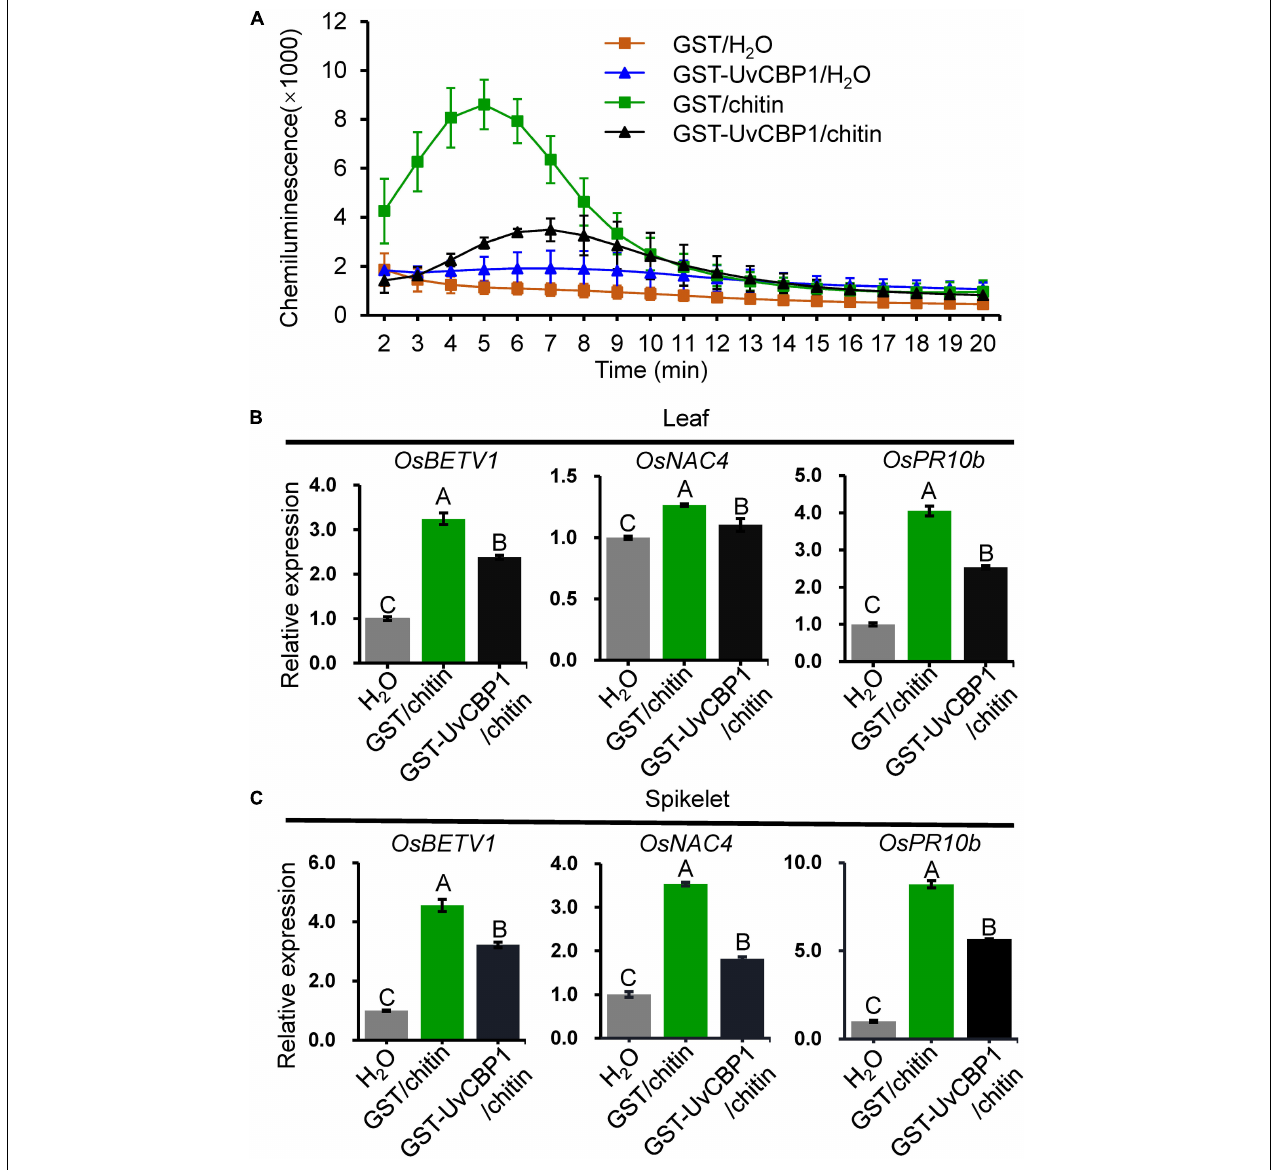
FIGURE 6 | UvCBP1 traps chitin from activating defense responses in rice. (A) Chitin-induced ROS burst in rice leaves. Chitin was co-incubated with GST-UvCBP1 or GST for 1 h, and then the resultants were used for inducing ROS. The data indicate the mean ± SD of three biological replicates. The experiment was repeated twice with similar results. (B,C) Chitin-induced expression of defense-related genes in rice leaves (B) or spikelets (C) . Chitin was incubated with GST-UvCBP1 or GST for 1 h, and then the resultants were used to treat rice leaves (for 12 h) or spikelets (for 6 h). Relative expression of indicated genes was determined using OsUbi as the reference gene. Data are represented as mean ± SD of three replicates. Different letters above data bars indicate significant difference as determined by one-way ANOVA with post hoc Tukey honestly significant difference (HSD) analysis ( P <